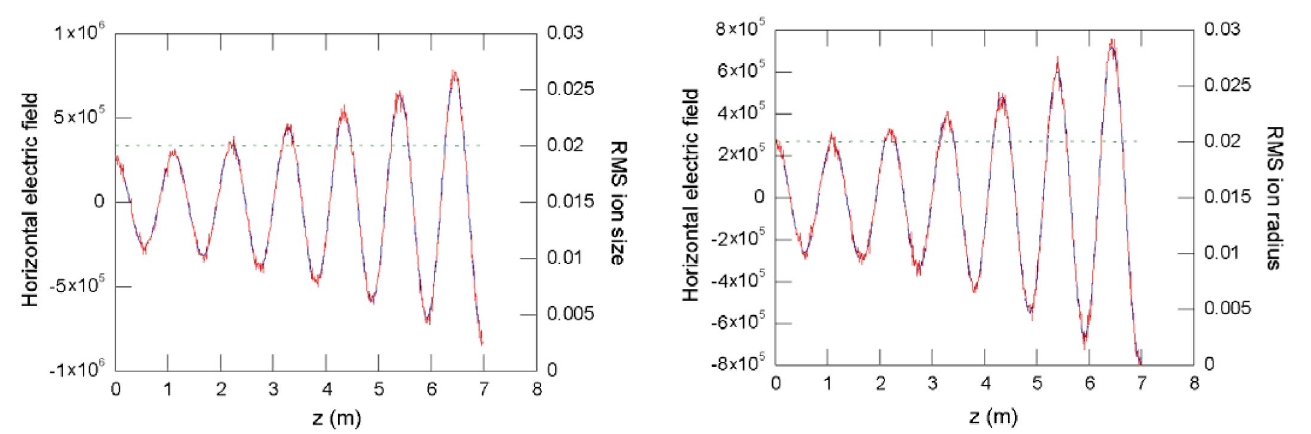
FIG. 10. (Color) Comparison of the electron centroid grid and analytic electric fields, using method 1. The solid red line shows the electric field calculated on the simulation grid, the dashed blue line shows the electric field calculated by the analytic model, and the dashed green line shows the rms ion size.